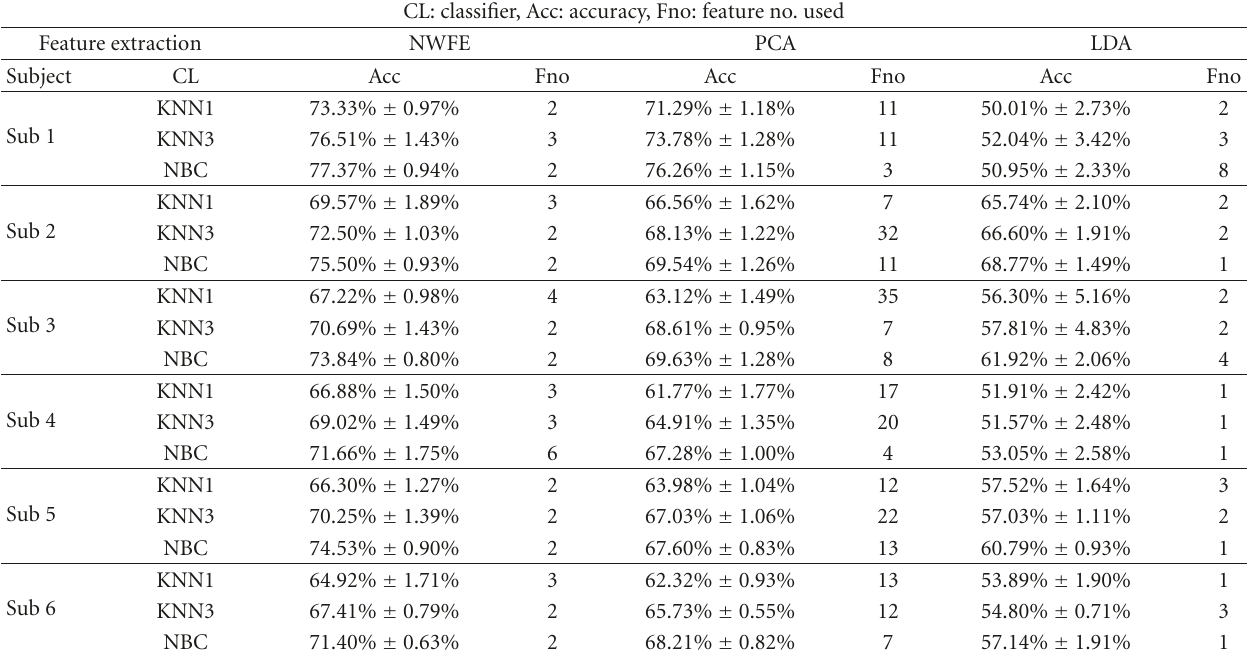
Table 1: Classification results. CL: classifier, Acc: accuracy, Fno: feature no.